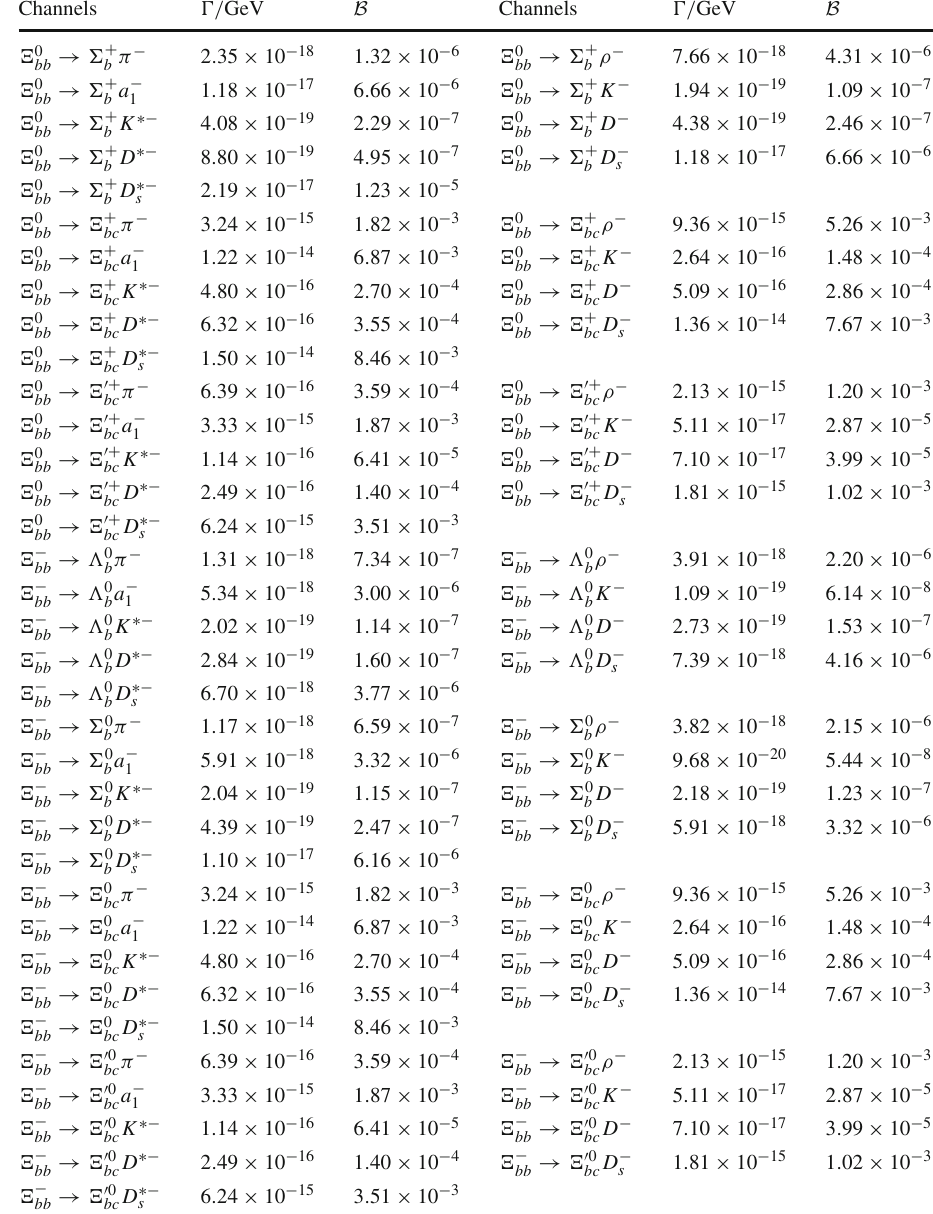
and branching ratios for nonleptonic decays of (cid:4) 0